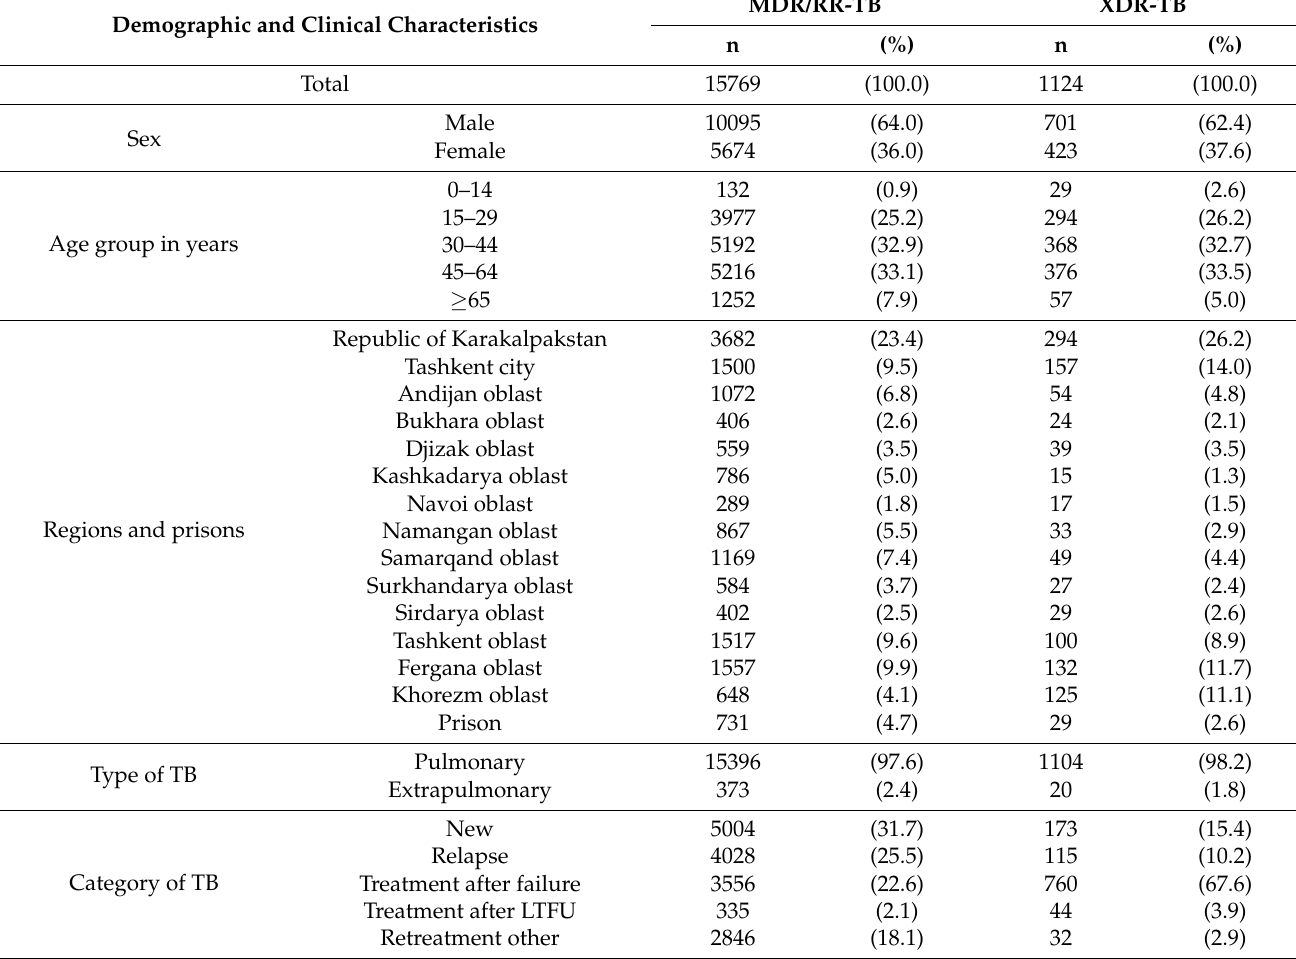
Table 2. Demographic and clinical characteristics of patients enrolled for MDR-TB and XDR-TB treatment in Uzbekistan between 2013–2018. Demographic and Clinical